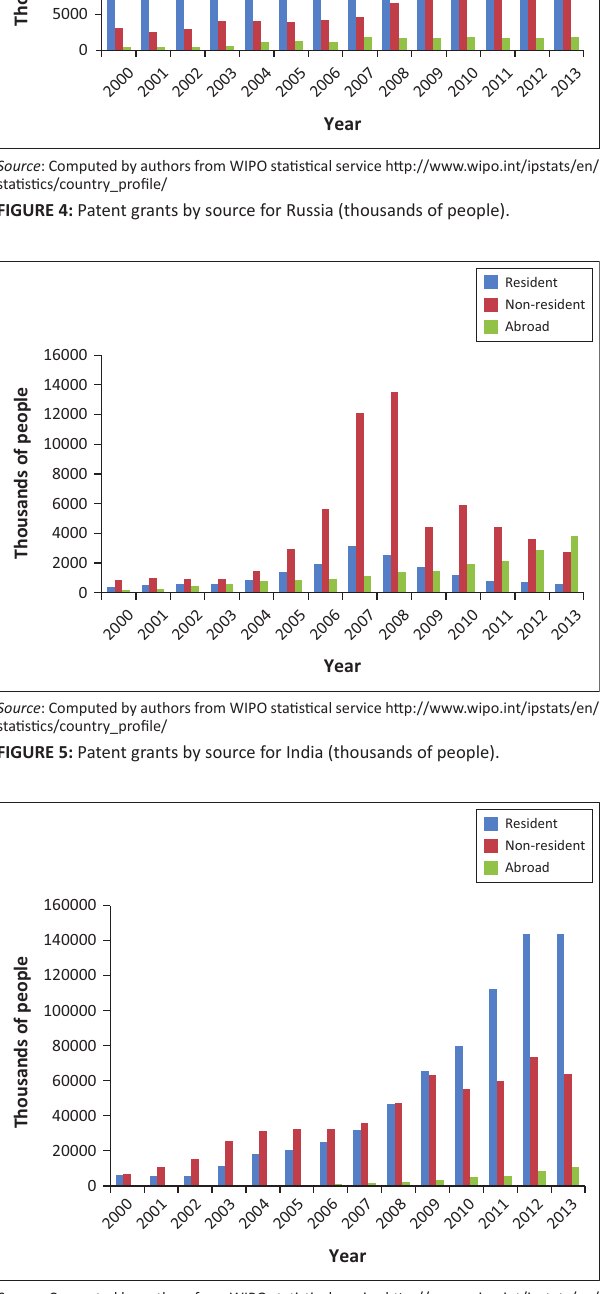
FIGURE 3: Patent grants by source for Brazil.